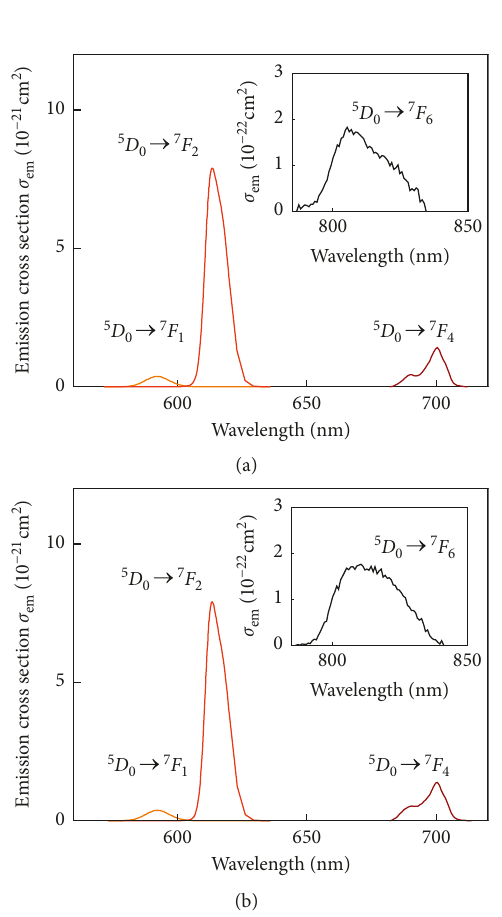
Figure 11: Emission cross-sectional profiles of Eu 3+ in Eu(BA)(TTA) 2 /PVP (a) and Eu(BA)(TTA) 2 Phen/PVP (b) under 367nm UVA-LED excitation. Insets: emission cross-sectional pro- files of 5 D 0 ⟶ 7 F 6 transition of Eu 3+ in Eu(BA)(TTA) 2 /PVP and Eu(BA)(TTA) 2 Phen/PVP,